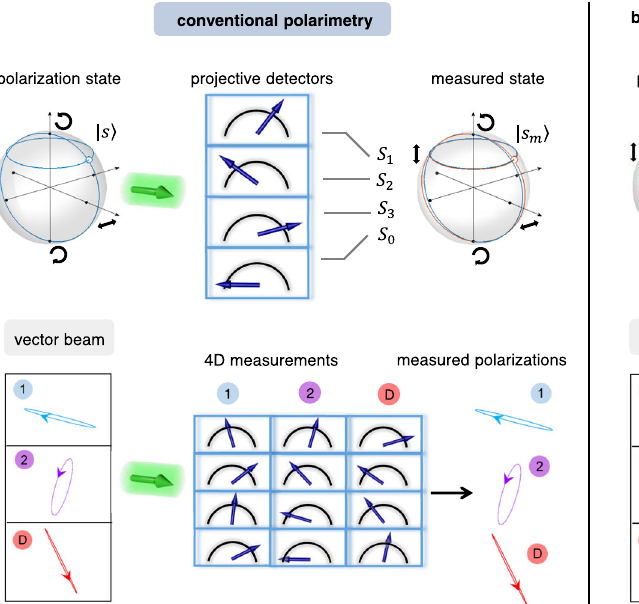
Fig. 1 | Observing many polarizations in a single shot. a Conventional polari- metry relies on projective measurements: the state of polarization (SOP) (cid:1) ∣ s i = ∣ S , a point on the Poincaré-Bloch sphere, is processed by distinct 1 , S 2 , S 3 , S 0 detectors, each analyzing one component. b Inour single-shot method,the SOP is mapped onto a high-dimensional phase space (false-color map) where data were collected. The black box represents the transformation setup, i.e., any optical